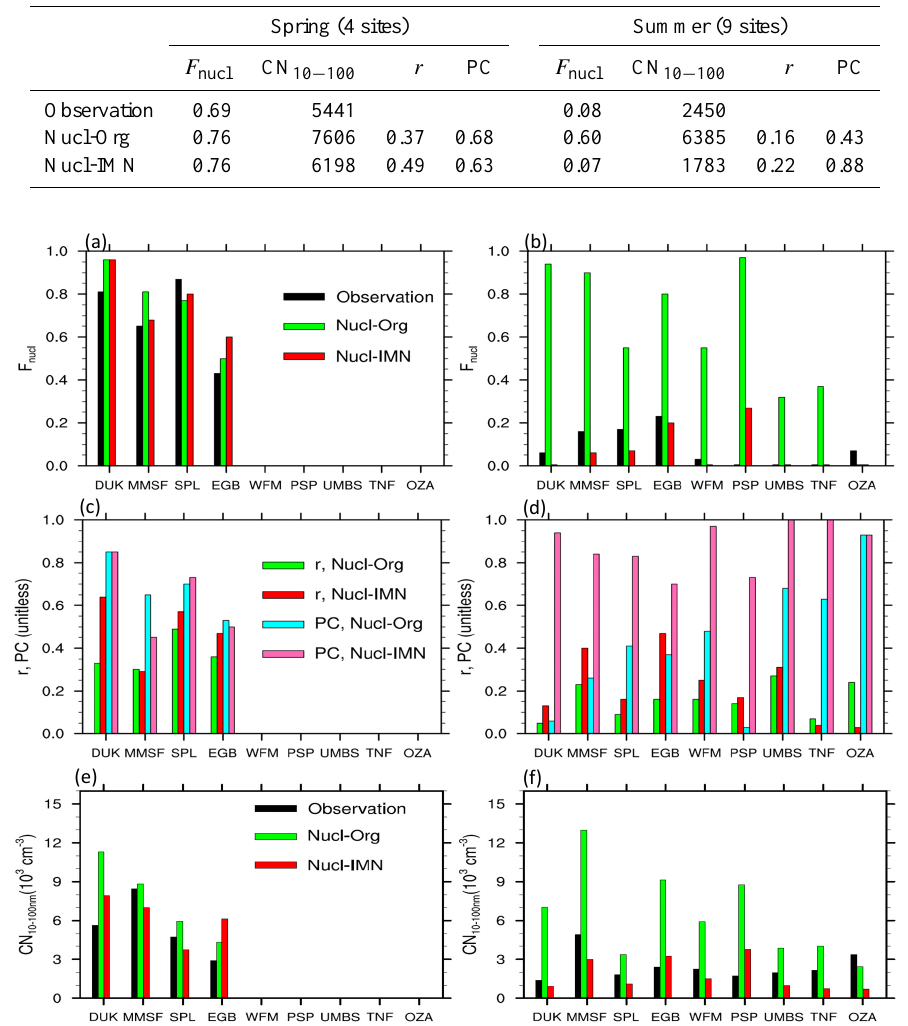
Figure 4. Statistical analysis of simulated NPF events and CN 10 − 100 based on two nucleation schemes (Nucl-Org, Nucl-IMN) and compar- ison with observations at four forest sites for the spring month (a, c, e) and nine sites for the summer month (b, d, f) . F nucl is the fraction (or frequency) of nucleation event days (a, b) . The proportion correct (PC) (c, d) is defined as (# of modeled events that were events + # of modeled non-events that were non-events) / (total # of modeled events + total # of modeled non-events). Monthly mean CN 10 − 100 (e, f) and correlation coefficient ( r ) (c, d) of hourly mean CN 10 − 100 during the month are also